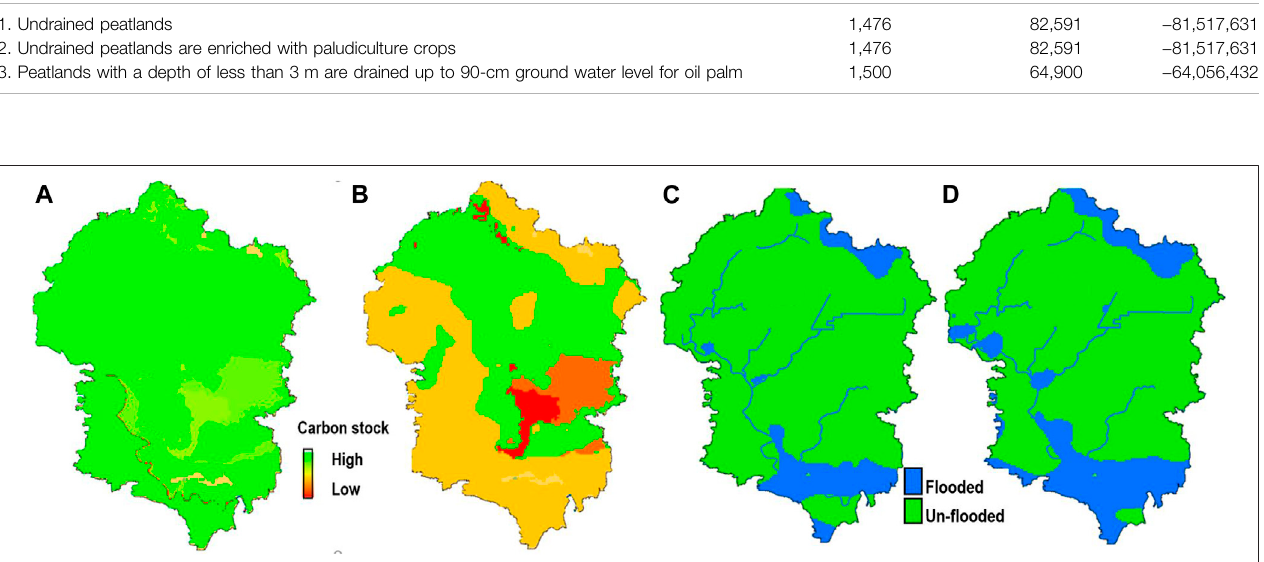
FIGURE 4 | InVEST carbon sequestration map due to the conversion of peat forest (A) into oil palm (B) ; fl ooded area due to the land-use conversion from peat forest (C) into oil palm (D) .